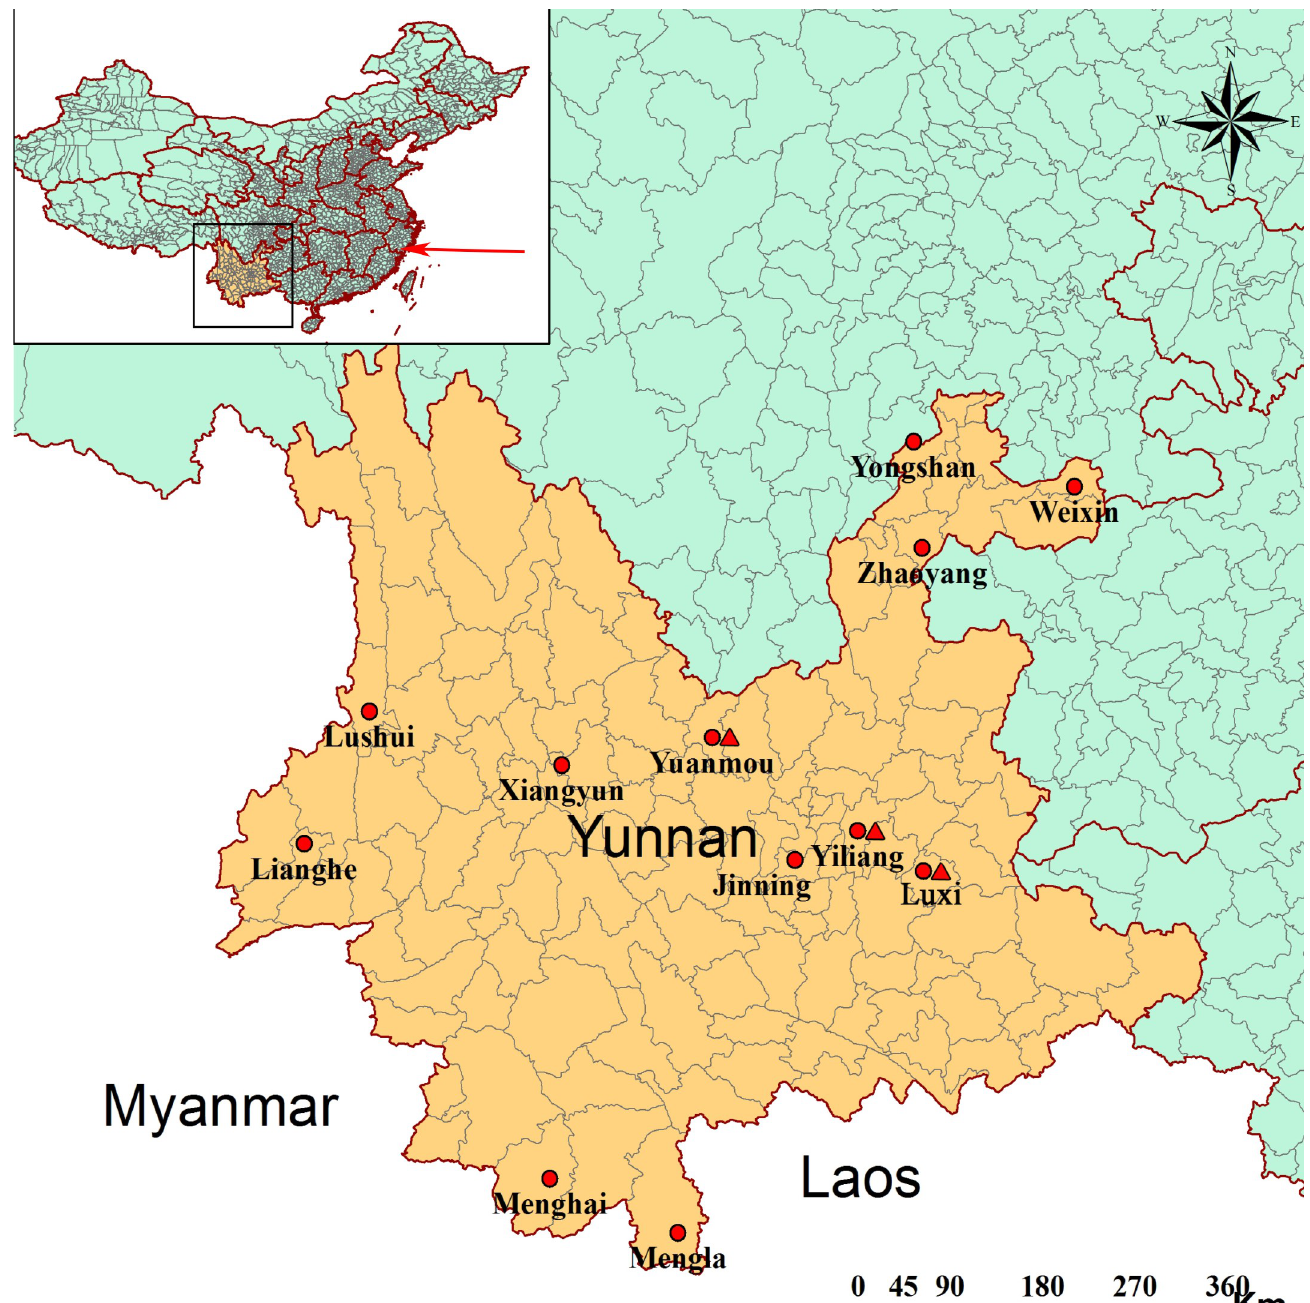
Fig 1. Map showing the small mammal collection sites in Yunnan Province of China. Sampling map drawn using QGIS Desktop 3.0.1 software. Red circles indicate sample collection sites, while red triangles indicate the sites where RNA virus was detected. The red arrow in the inset map indicates the location (We¯nzh ō u city) where WENV was reported for the first